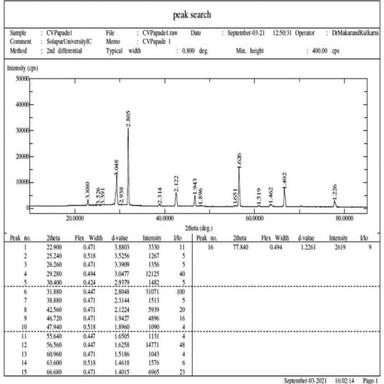
XRD analysis of PCM (NANO3 (60%) + KNO3 (40%).